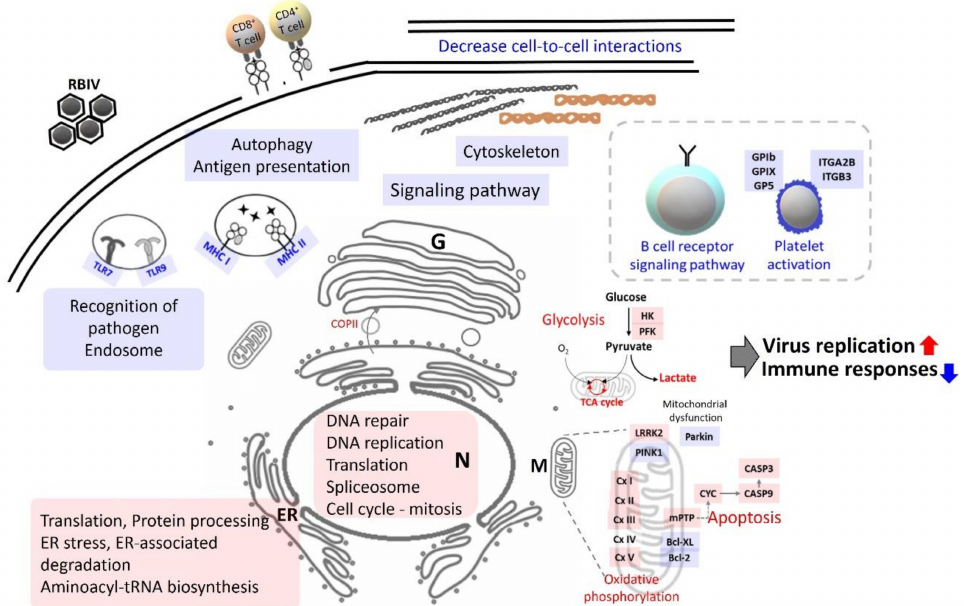
Figure 6. Schematic proposal showing how rock bream iridovirus (RBIV) could interact with cells in spleen of heavy-infected rock bream. Red and blue colors indicate up- and down-regulation, respectively, in host cells. N, Nucleus; ER, endoplasmic reticulum; G, Golgi apparatus; M, mitochondria; TLR, Toll-like receptor; MHC, major histocompatibility complex; Cx, Complex; COPII, coat protein